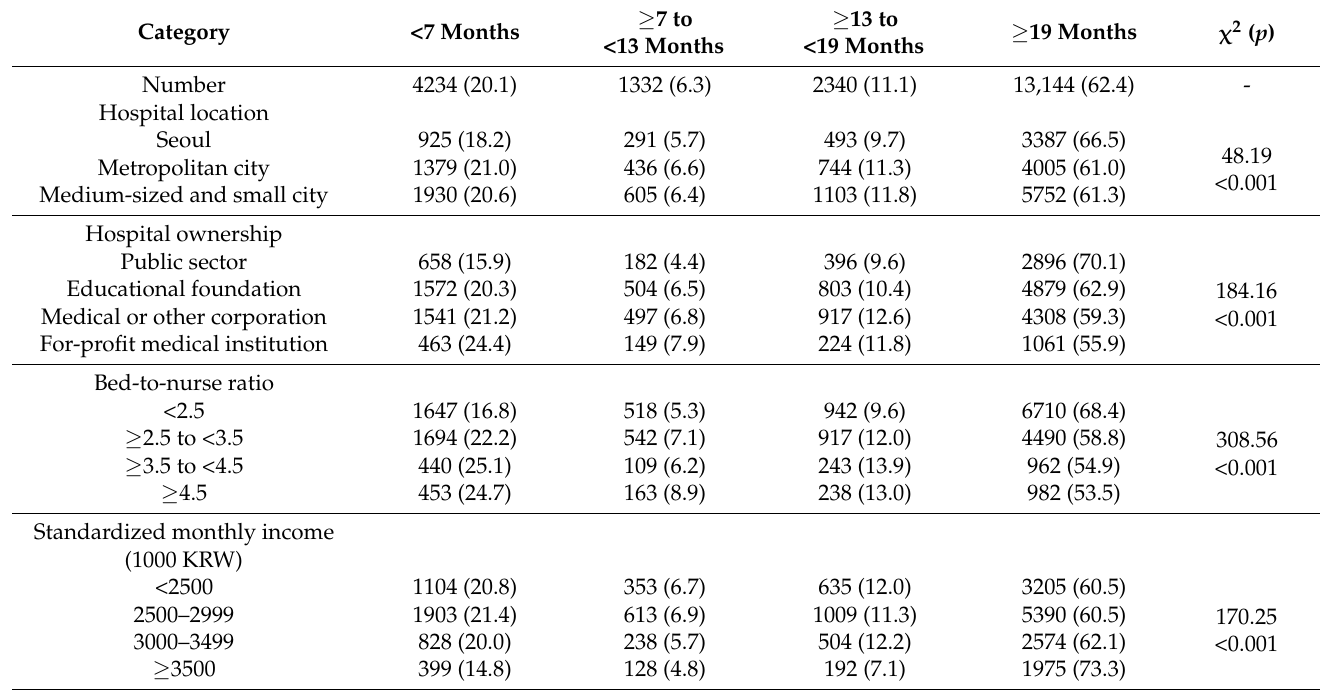
Table 2. Differences between the retention periods of newly hired nurses according to organizational characteristics ( n = 21,050).